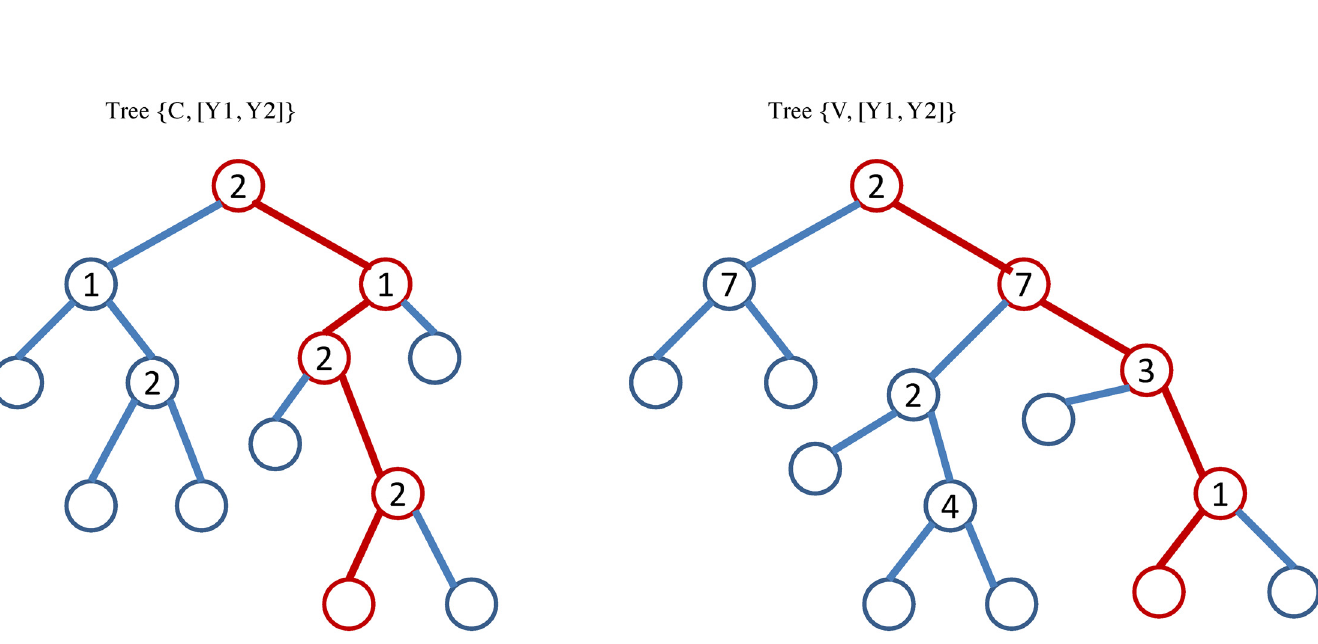
PLOS ONE | DOI:10.1371/journal.pone.0144490 December 10, 2015 11 /